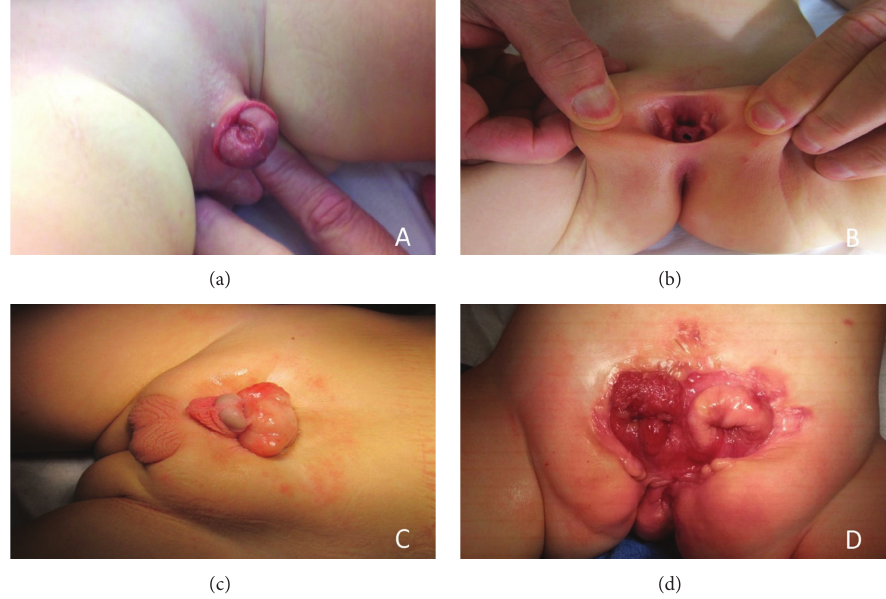
Figure 1: Four presentations of the exstrophy-epispadias complex: (a) complete male epispadias, (b) complete female epispadias, (c) classic bladder exstrophy, and (d) cloacal